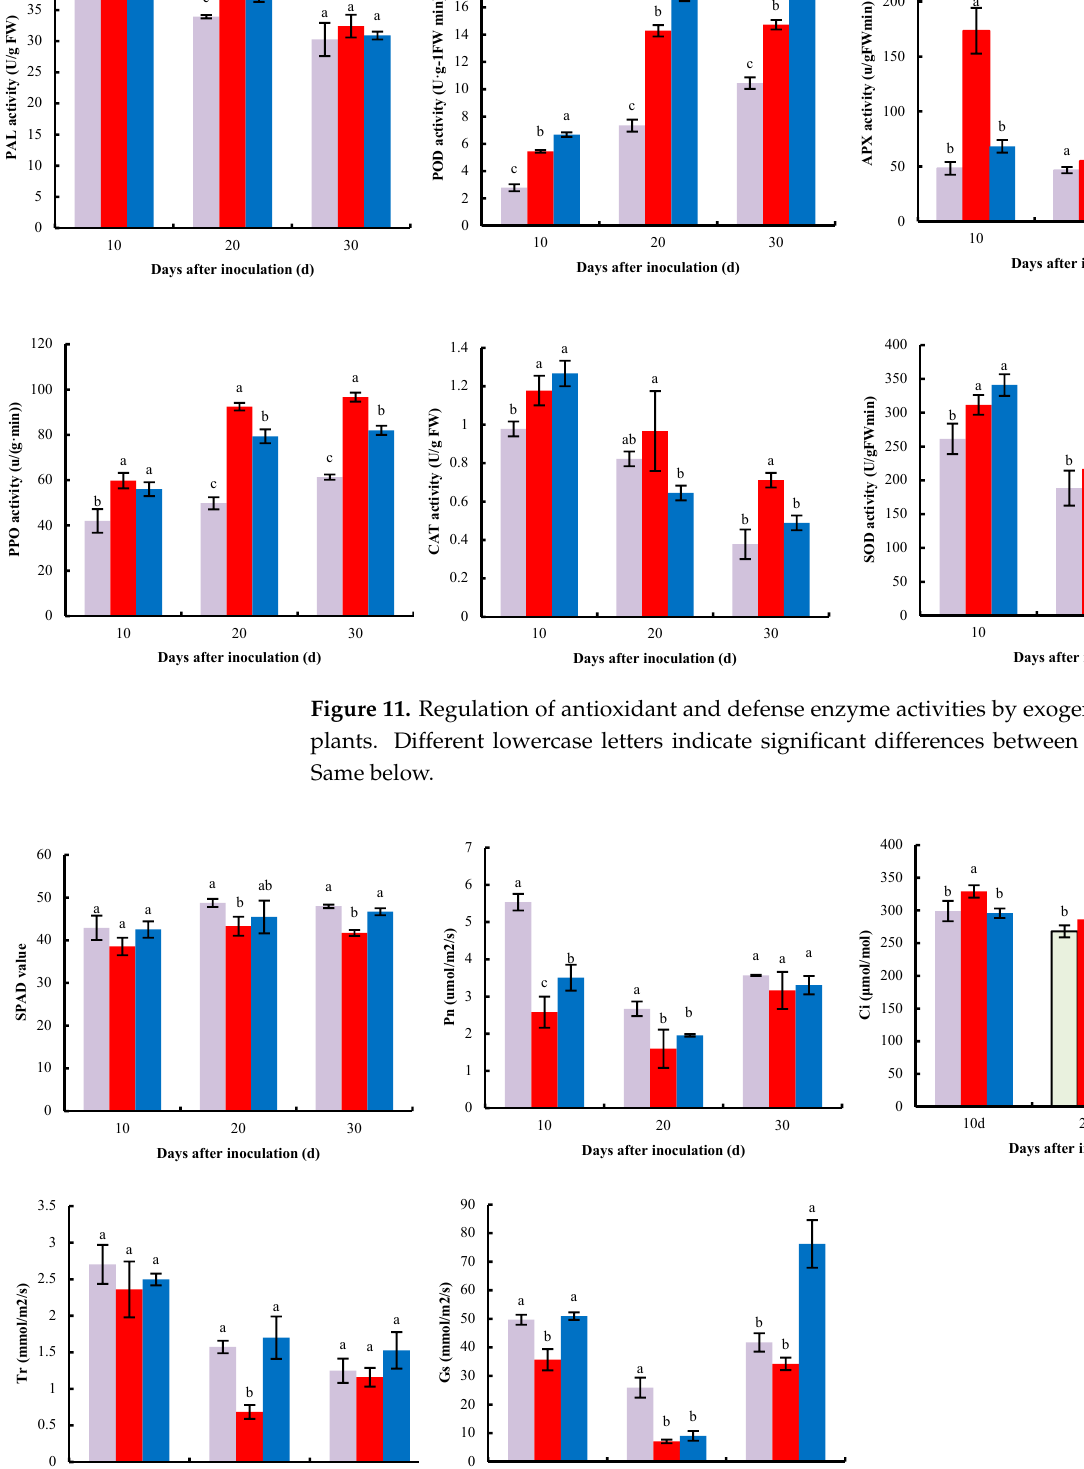
Figure 12. Regulation of chlorophyll content, Pn, Ci, Tr, and Gs in diseased plants by exogenous NO. Different lowercase letters indicate significant differences between treatments, p < 0.05. Same below.